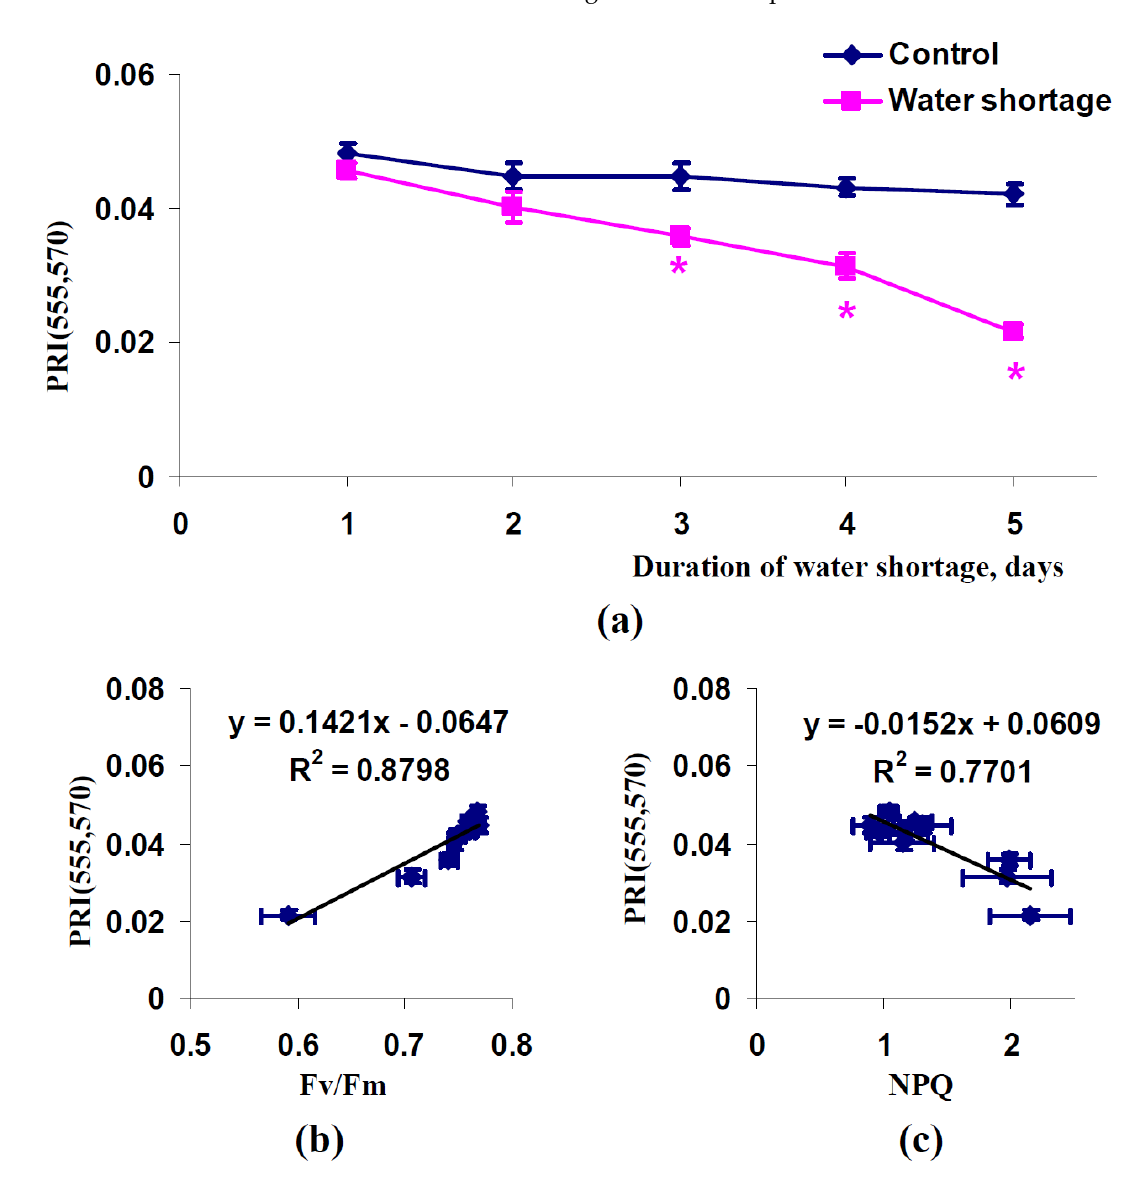
Figure 4. Dependence of the modified photochemical reflectance index calculated on the basis of 555 and 570 nm wavelengths (PRI(555,570)) in spatially-fixed leaves of pea plants on duration of water shortage ( n = 5–6) ( a ) and dependences of average values of PRI(555,570) on Fv/Fm ( b ) and NPQ ( c ) ( n = 10). Average values of Fv/Fm and NPQ from Figure 2 were used. R 2 is the determination coefficient. *, difference between experimental and control indices was significant ( p < 0.05).